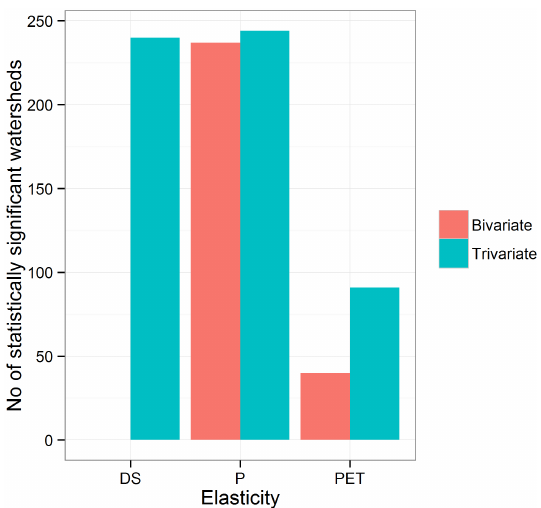
Figure 4. Number of statistically significant watersheds ( p <0.1) for the elasticities of bivariate and trivariate